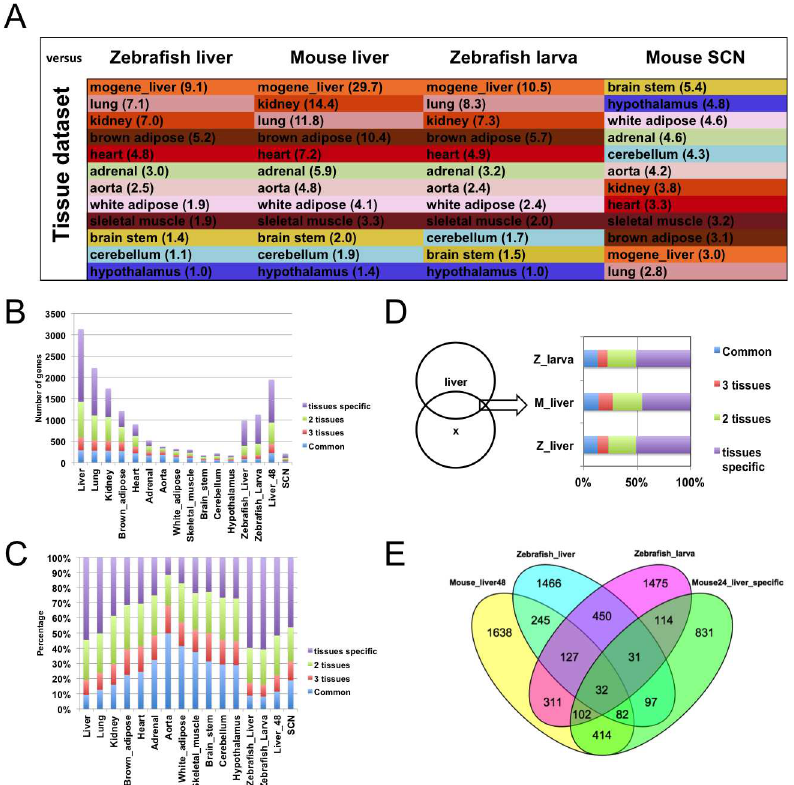
Fig 4. Zebrafish and mouse liver rhythmic genes compared to 12 mouse tissue time courses. (A) Color-coded table displayingthe ranking from highest to lowest of the Tanimoto-Jaccard index from the comparisonof the Zebrafish or Mouse liver time courses against 12 different tissues time courses from Zhang et al. [12]. As controls, Zebrafish larval and Mouse SCN datasets were also comparedwith the 12 tissues ensemble.(B) Number of common (present in 4 to 12 tissues) or tissue specific genes (presentin 1 to 3 tissues) in the 12 tissues and surveyeddatasets. (C) Proportionof common (present in 4 to 12 tissues) or tissue specific genes(present in 1 to 3 tissues) in the 12 tissues and surveyeddatasets. (D) Proportionof common (present in 4 to 12 tissues) or tissue specific genes(present in 1 to 3 tissues) in the intersection of the Venn diagrambetweenthe mouse liver and the Zebrafish larval, liver or Mouse liver (Liver_48)time courses. (E) Venn diagram betweenthe completemouse liver (Liver_48), Zebrafish liver and larval datasets and the liver specific subset from the mouse liver in